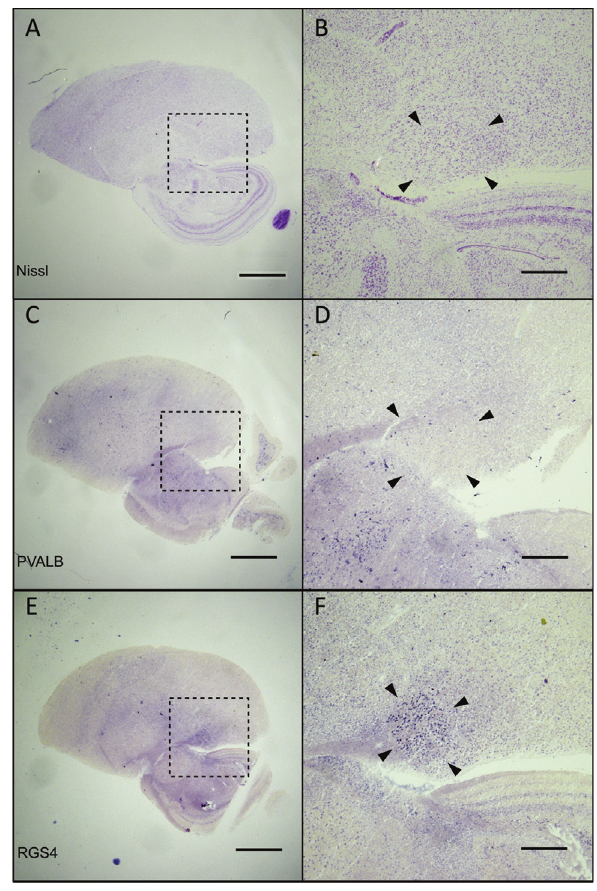
Figure 2 - An RA-like region in the brain of the antbird Wllisornis poecilinotus . (A) Nissl stained section of the W. poecilinotus brain, with the arcopallium region denoted by a dashed line box. (B) RA like nucleus characterized by the presence of large neuronal cells that are distinct from the surrounding cells. (C) Expression pattern of the song nuclei marker PVALB in a brain section of W. poecilinotus and (D) within the arco- pallium. (E) Expression pattern of the song nuclei marker RGS4 in a brain section of W. poecilinotus and (F) within the arcopallium. Arrowheads in- dicate the location of the RA-like nucleus. Scale bars are 20 (cid:2) m (A, C, E) and 5 (cid:2) m (B, D,